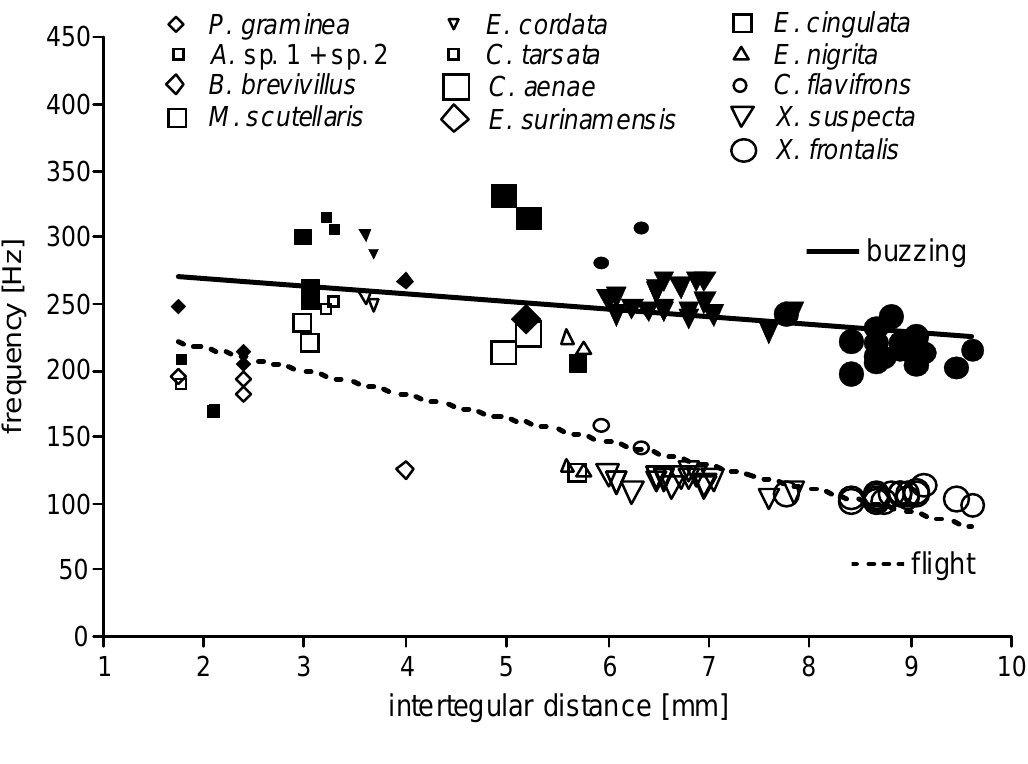
F IG . 1. Correlation of intertegular distance as a standard for bee size and the frequency of buzzing (solid symbols) and the frequency of flight (open symbols). Each symbol stands for a collected individual. All individuals of a species were assigned the same symbol. Linear regression is indicated by the lines, solid for buzzing frequency and dotted for flight frequency .